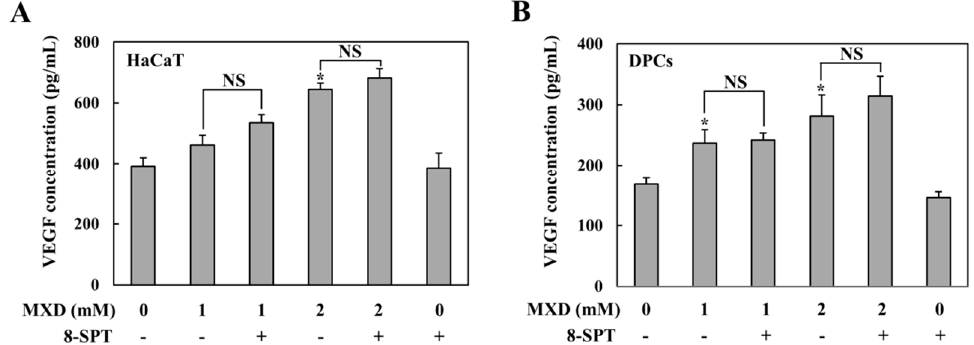
Figure 1. Millimolar minoxidil increases the secretion of vascular endothelial growth factor (VEGF) independently of adenosine receptors. ( A ) Human keratinocytes (HaCaT cells) were treated with minoxidil (MXD) for 10 h in the presence 8-SPT (1 µ M), an adenosine receptor antagonist, and VEGF secretion was monitored in cell culture supernatants by ELISA; ( B ) the same experiment was performed in human dermal papilla cells (DPCs). The data represent the mean ± standard error of the mean (SEM) ( n = 5). * p < 0.05 versus untreated group. NS: not significant.